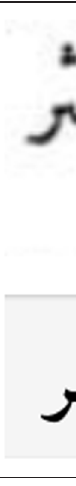
Figure 12: Atypical dot